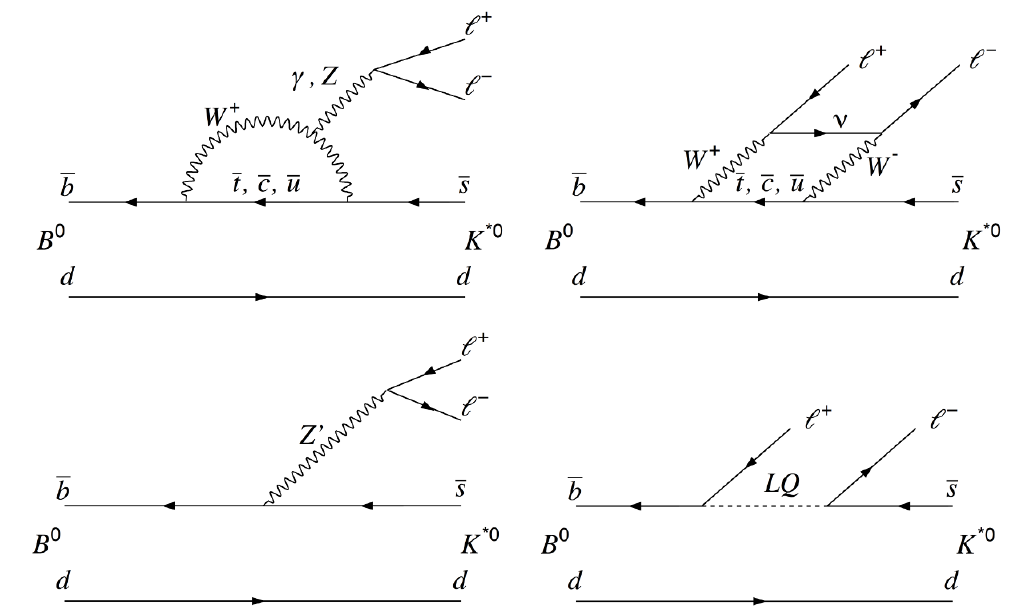
Figure 1 . Feynman diagrams in the SM of the B 0 ! K (cid:3) 0 ‘ + ‘ (cid:0) decay for the (top left) electroweak penguin and (top right) box diagram. Possible NP contributions violating LU: (bottom left) a tree- level diagram mediated by a new gauge boson Z 0 and (bottom right) a tree-level diagram involving a leptoquark LQ